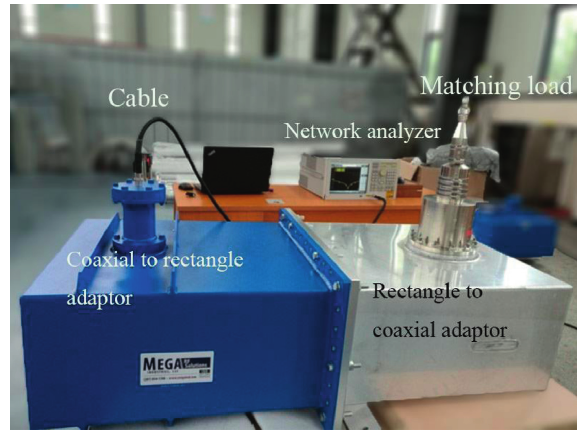
Figure 6: Photograph of the test system.